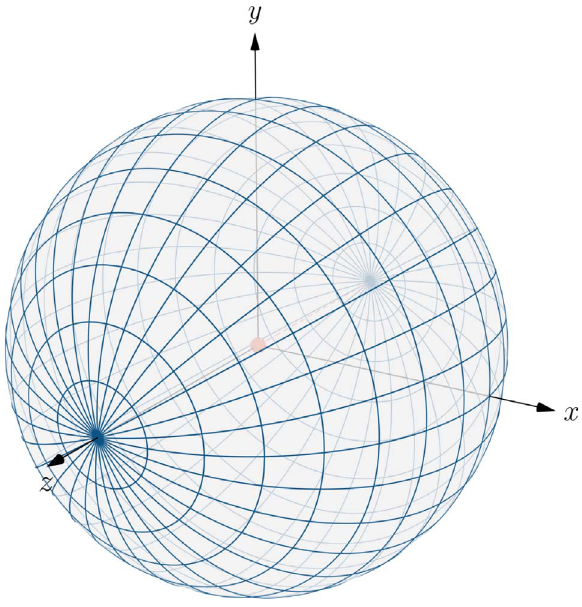
Figure 2. Partitioning of sphere into 32 (cid:5) 16 sections with equal angle distribution (EA 512 grid).